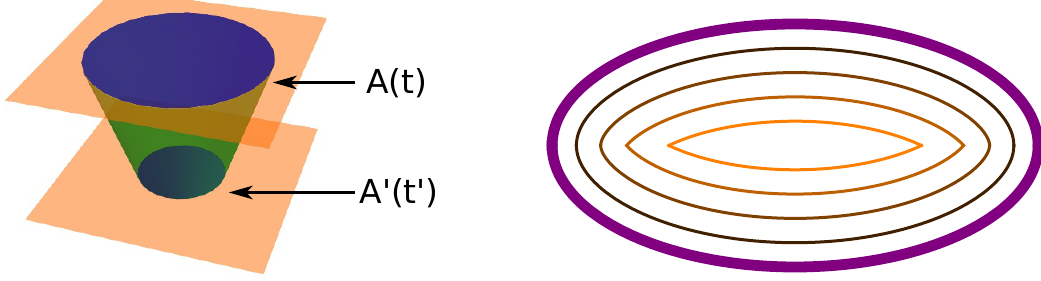
Figure 1 . Left: the \ v LC cone" for a disk A 0 ( t 0 ) passes through A ( t ). Any information in A 0 ( t 0 ) is contained in A ( t ), hence A 0 ( t 0 ) is a subsystem of A ( t ) and we can use the monotonicity of relative entropy (2.1). Right: the tsunami wavefront for di(cid:11)erent times corresponding to the case where @A is an ellipse (purple). Lighter color means later